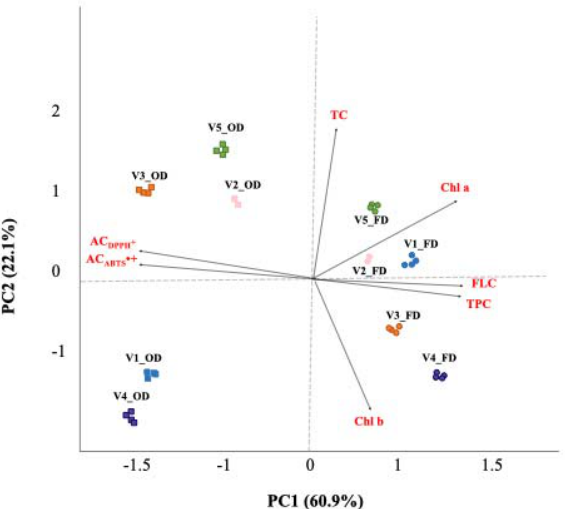
Figure 6. Biplot obtained by combining information from nutraceutical and antioxidant properties of samples analyzed. OD—oven-dried samples; FD—freeze-dried samples. V1—Chinook hop leaves; V2—Centennial hop leaves; V3—Comet hop leaves; V4—Columbus hop leaves; V5—Cas ‐